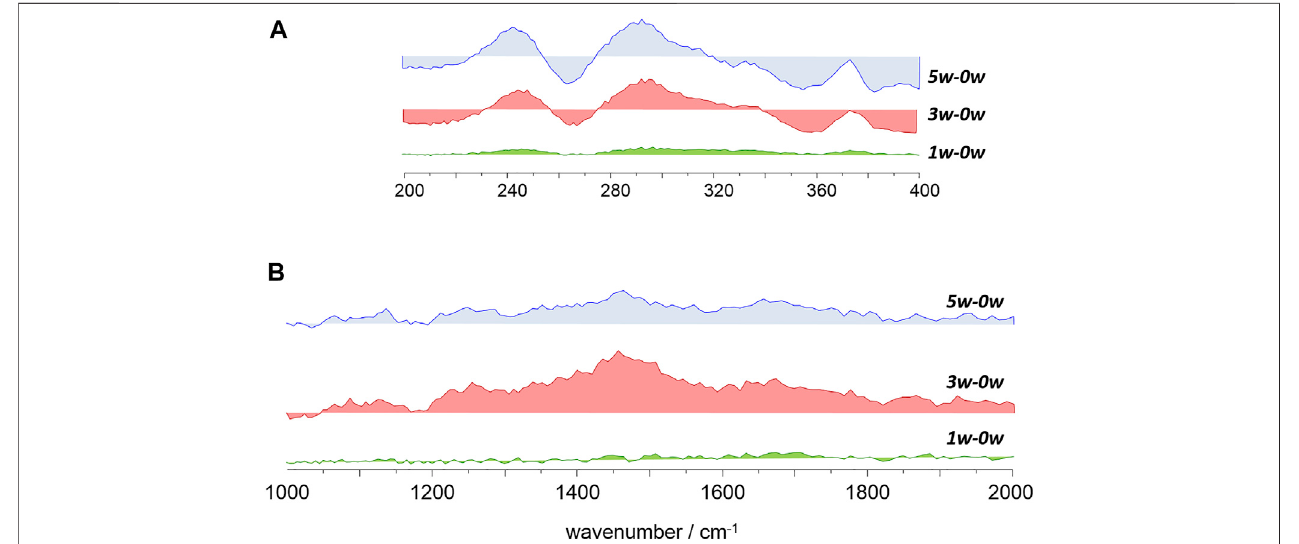
FIGURE 8 | INS difference spectra ( wet minus dry, n w-0w, n = 1, 3, 5) of the ChCl:glycerol mixture, for the 200 – 400 cm − 1 (A) and 1,000 – 2000 cm − 1 (B) regions.